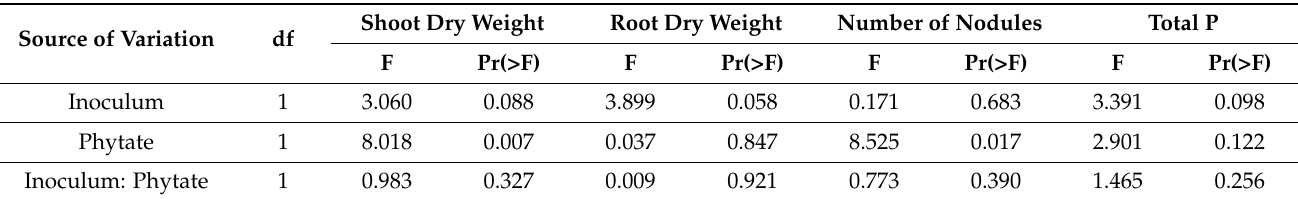
Table 1. Two-way ANOVA from the effects of treatment on fresh and dry weight of shoot and root, nodule formation and total phosphorus.